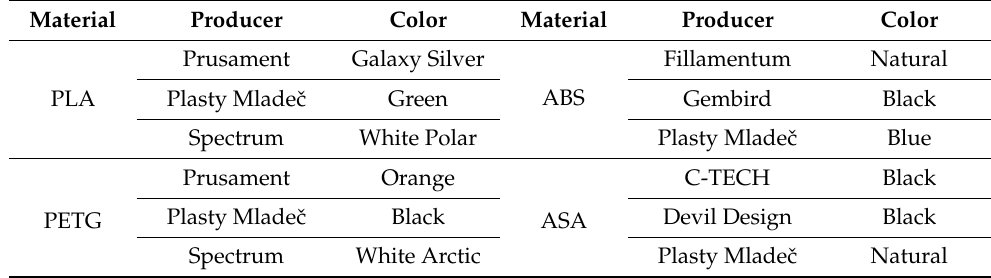
Table 1. Overview of materials used and individual manufacturers.